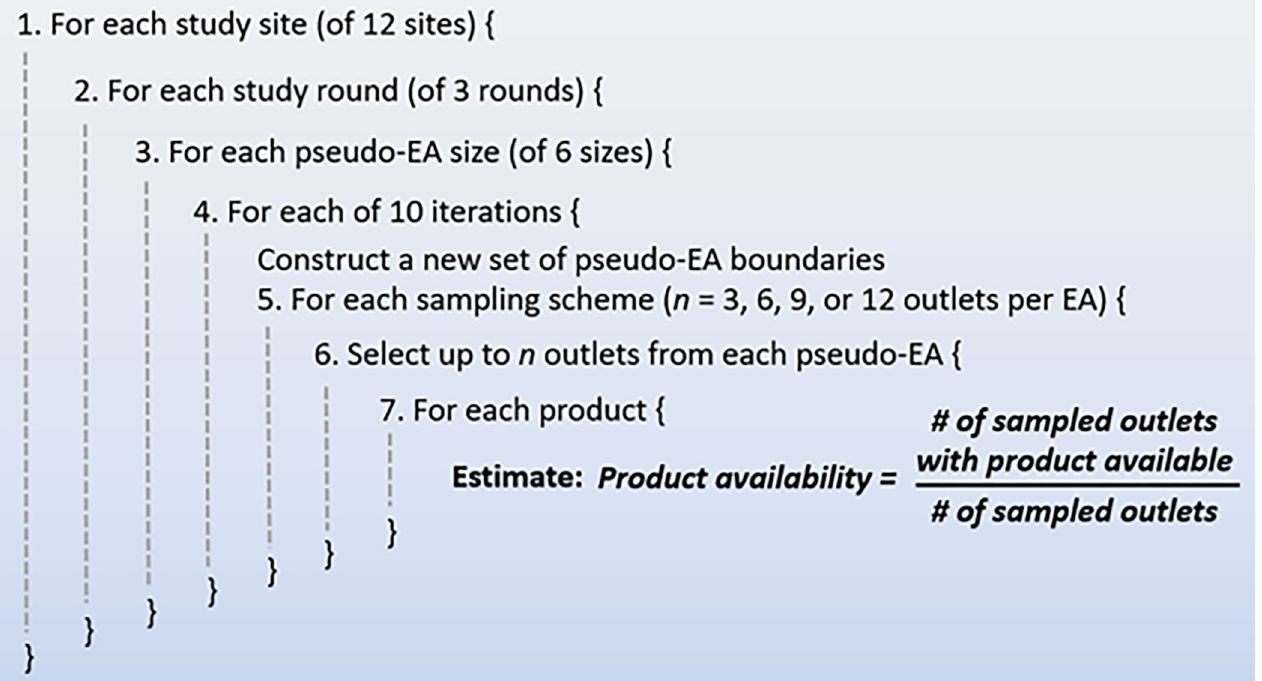
Fig 2. Structure of simulation to create pseudo-EAs, sample outlets, and estimate product availability. This schematic describes the structure of the simulation used to create pseudo-EAs and repeatedly draw samples within them to calculate indicators within each study site, study round, and size of pseudo-